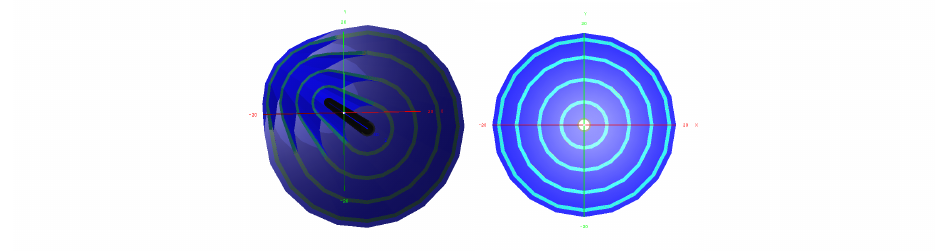
Figure 5. Cylindrical GEM Inner Tracker, described in the DD4HEP simulation.